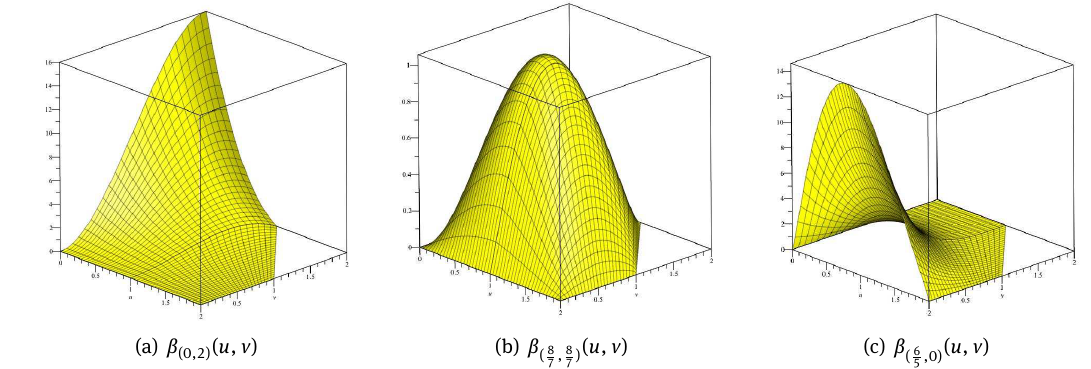
Figure 5: GT-Bernstein basis functions.